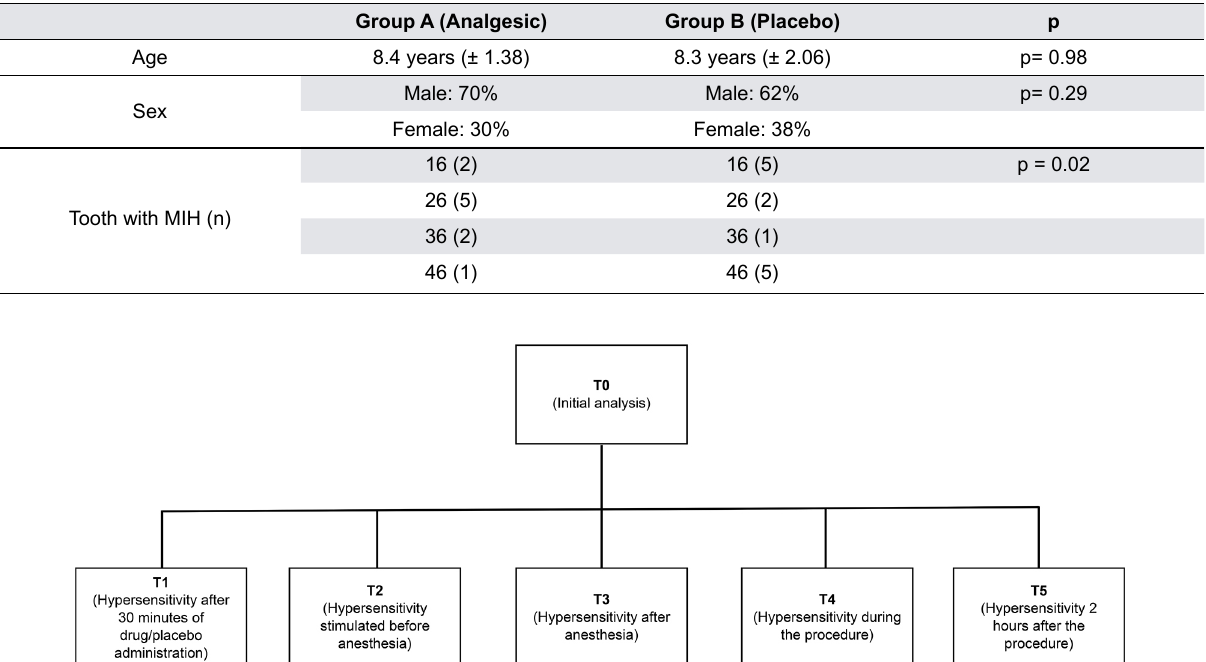
Figure 3- Evaluation time points